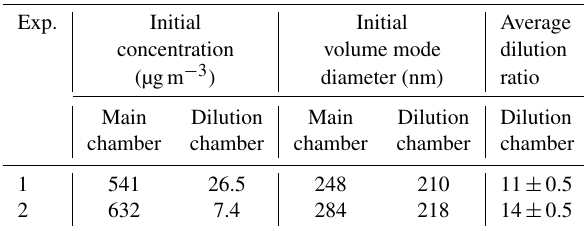
Table 1. Summary of the experimental